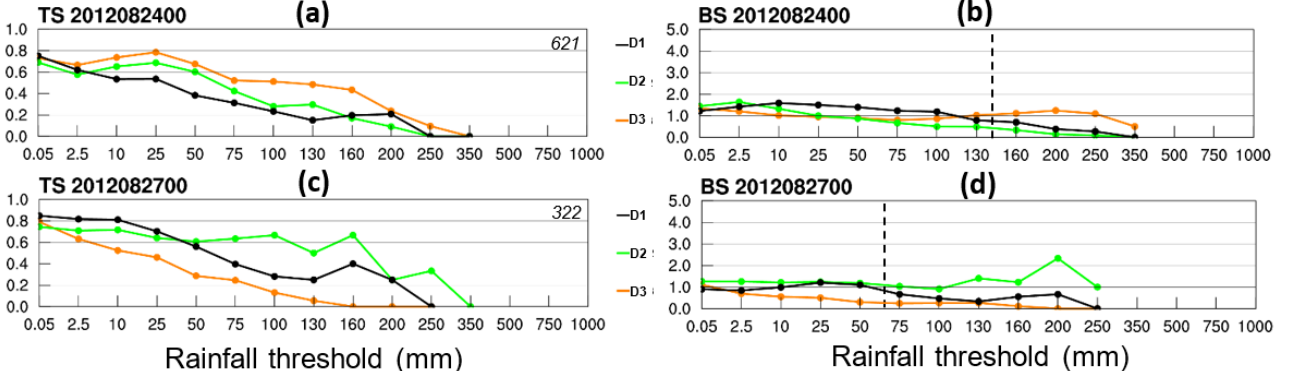
Figure 10. Similar to Figure 5, except for TS and BS of CReSS QPFs from the three forecasts made at 0000 UTC of ( a , b ) 22–24 August (at ranges of days 1–3) but all targeted for 24 August (0000–2400 UTC), and of ( c , d ) 25–27 August but all targeted for 27 August, respectively, during TY Tembin (2012). For the 24 h target period, the observed maximum rainfall (mm, rounded to integer, in TS plots) and base rate ( O / N ) at 10% (vertical dashed line, in BS plots) are both given.